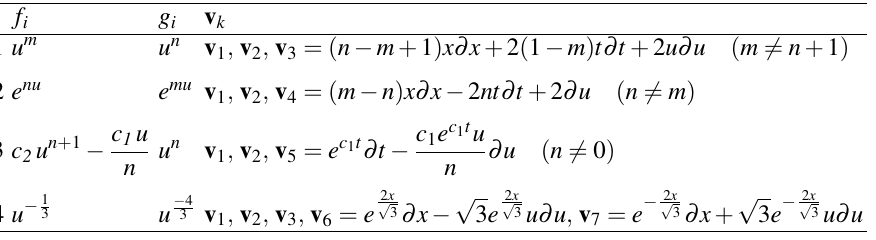
Table 2: Optimal